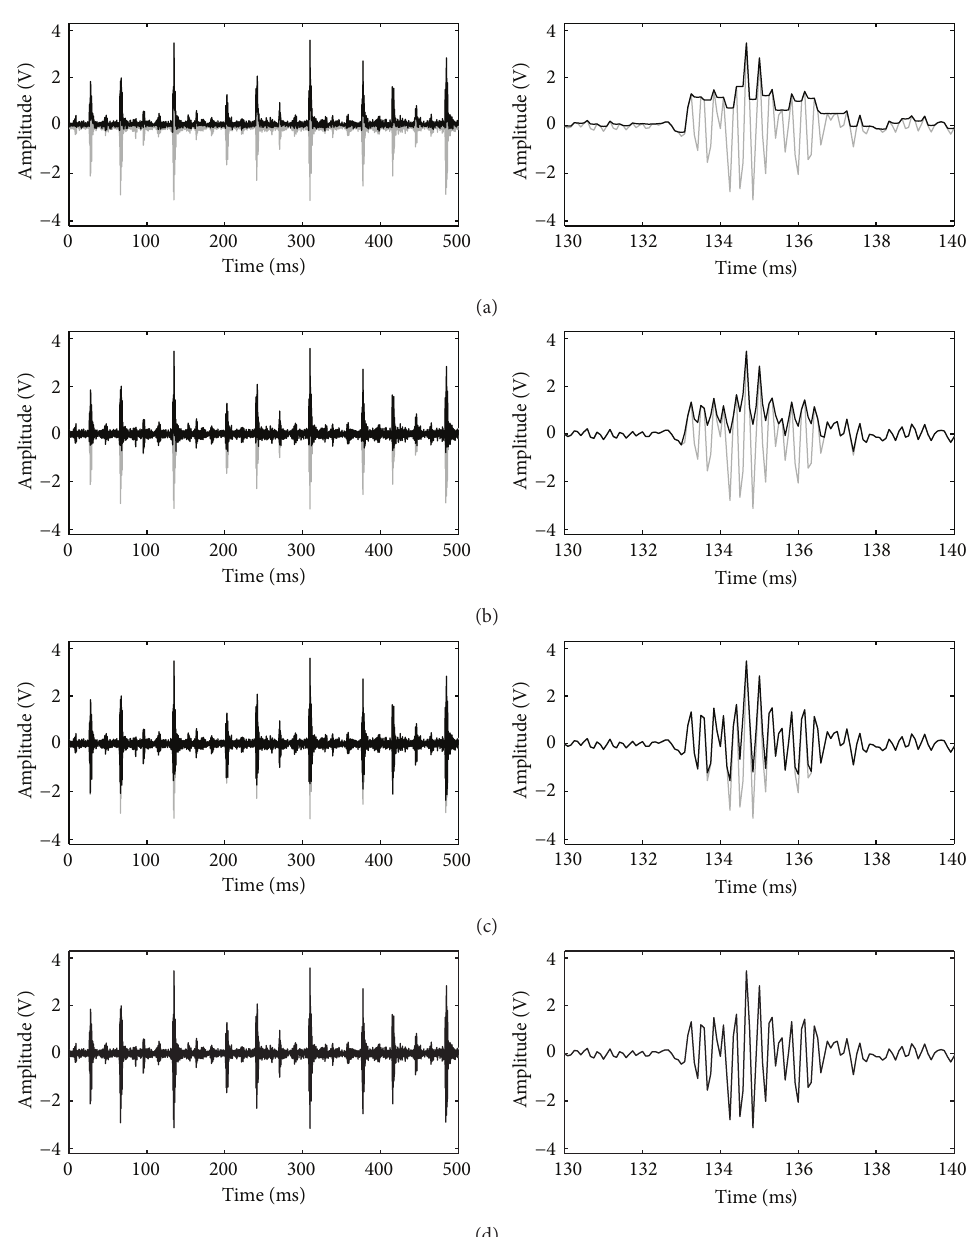
Figure 2: Signal after closing operation by triangular SEs with different heights: (a) ℎ = 0.01 , (b) ℎ = 0.7 , (c) ℎ = 2.3 , and (d) ℎ = 10 .